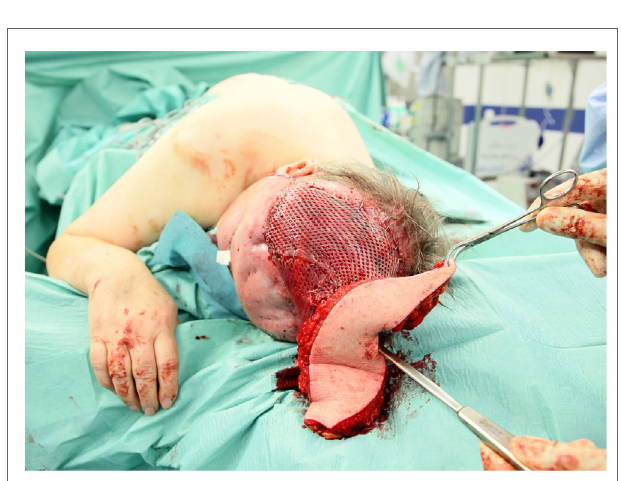
FiGURe 3 | After fitting of the flap . Note the skin grafted muscle surface with leaves only small gaps for the vessels.